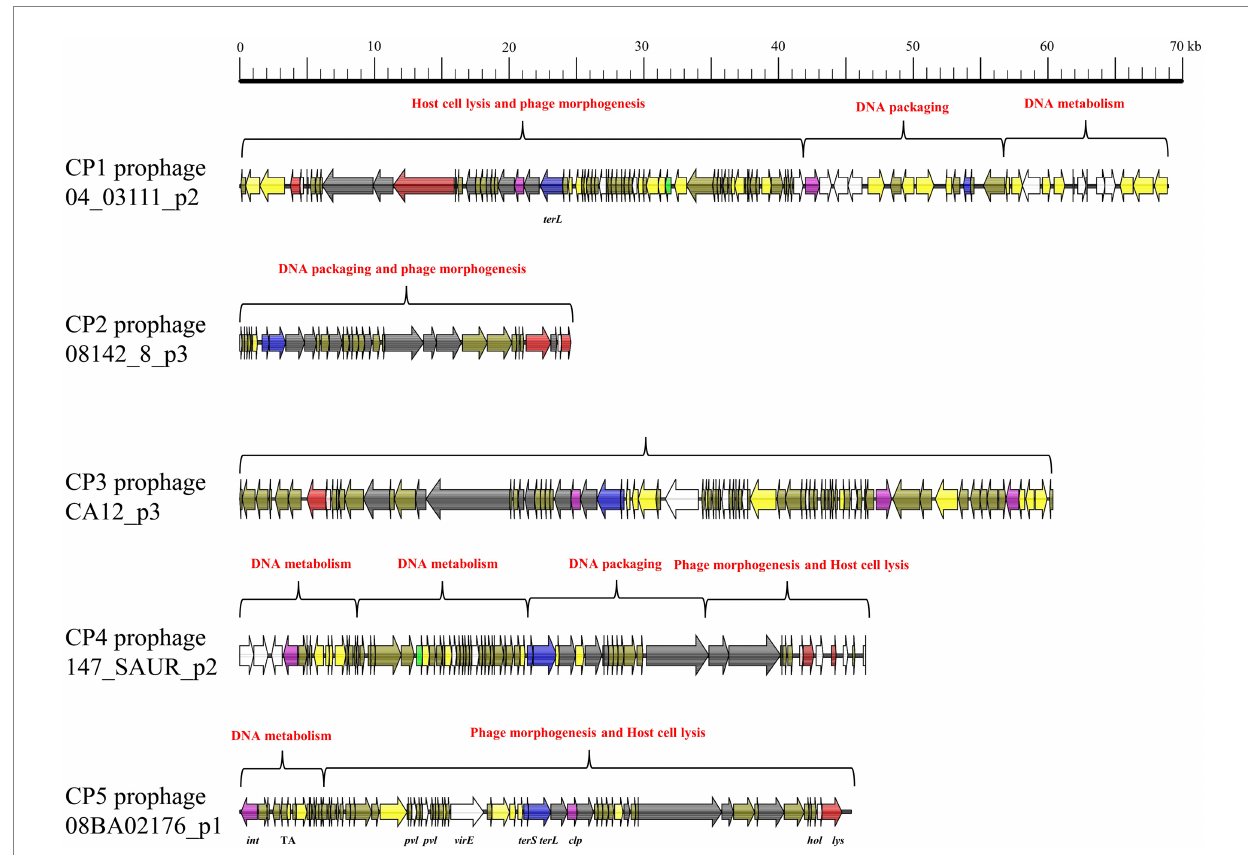
FIGURE 1 Mosaic pattern of the primary structure of intact prophages CP1–5. Functional modules are annotated with different colors. ORFs are represented by arrows indicating the transcription direction, and the colors of the arrows represent different genes. Gene color: virulence determinants, white; holin- encoding gene, pink; lysin-encoding gene, red; genes associated with lysogeny, purple; bla , green; DNA packaging genes, blue; DNA metabolism genes, yellow; and hypothetical protein genes,